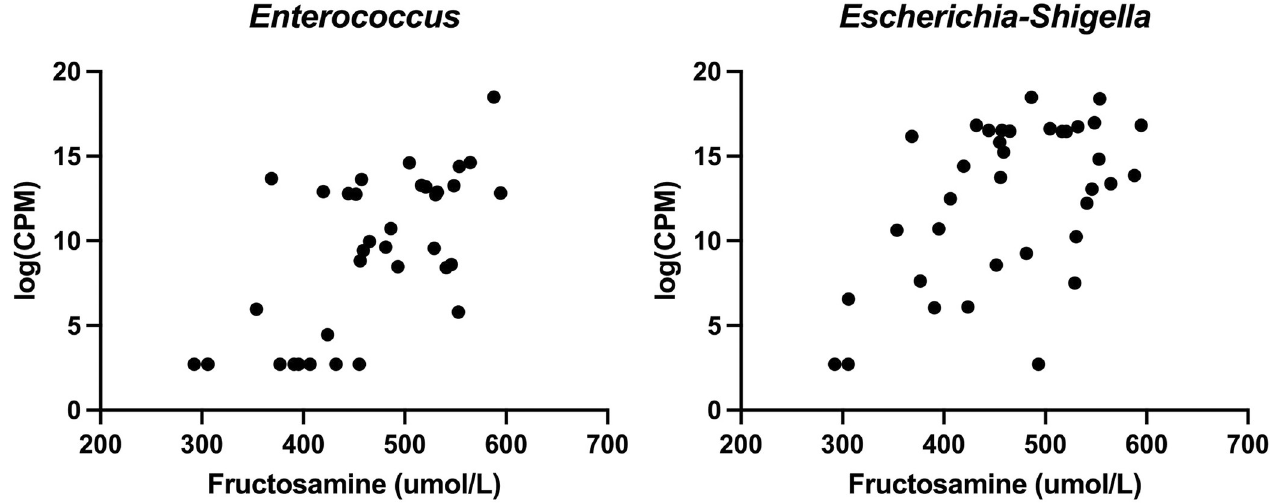
Fig 6. Fructosamine vs. relative abundance of ASVs associated with fructosamine concentration.